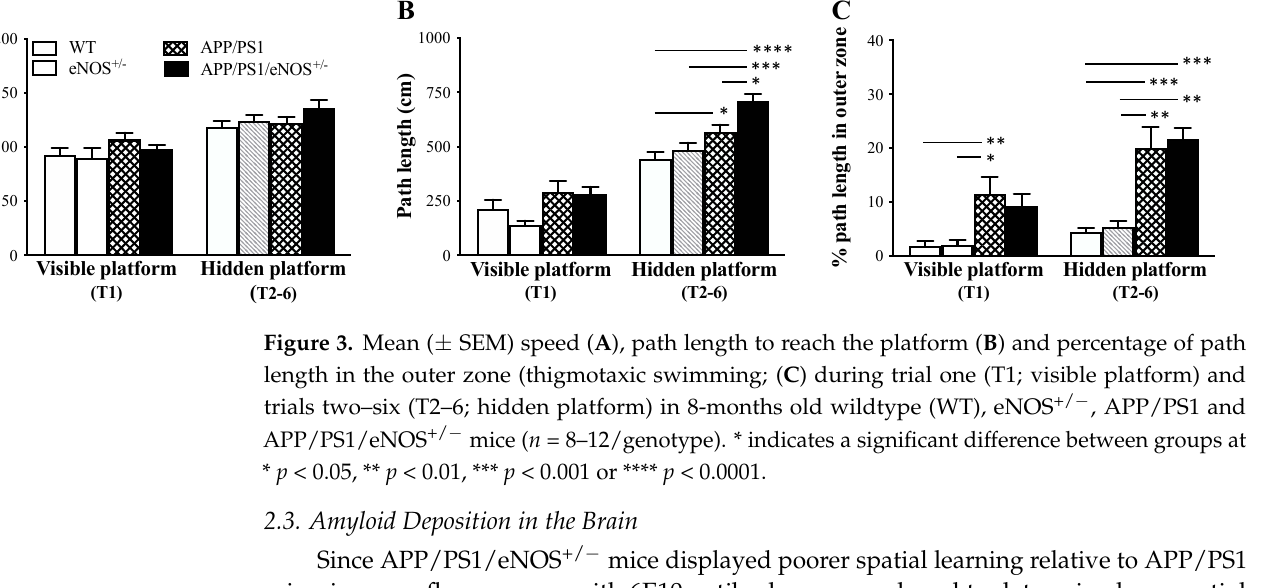
Figure 2. Mean ( ± SEM) path length ( A ) and % time in the outer zone ( B ) in the open field, time (s) spent in the open arms ( C ) and close arms ( D ) in the elevated plus maze, and the total number of arm entries ( E ) and the percentage of spontaneous alternation ( F ) in the Y-maze in 8-months old wildtype (WT), eNOS +/ − , APP/PS1 and APP/PS1/eNOS +/ − mice ( n = 8–12/genotype). * indicates a significant difference between groups at * p < 0.05 or ** p < 0.01.